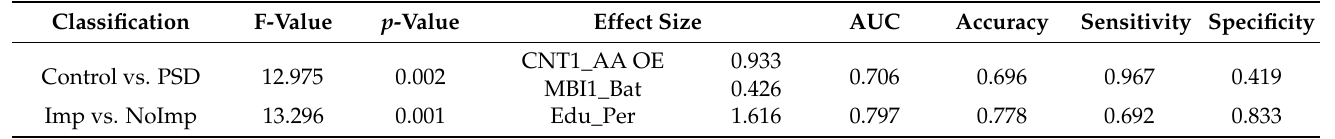
Table 7. Parameters of the logistic regression and their assessment.